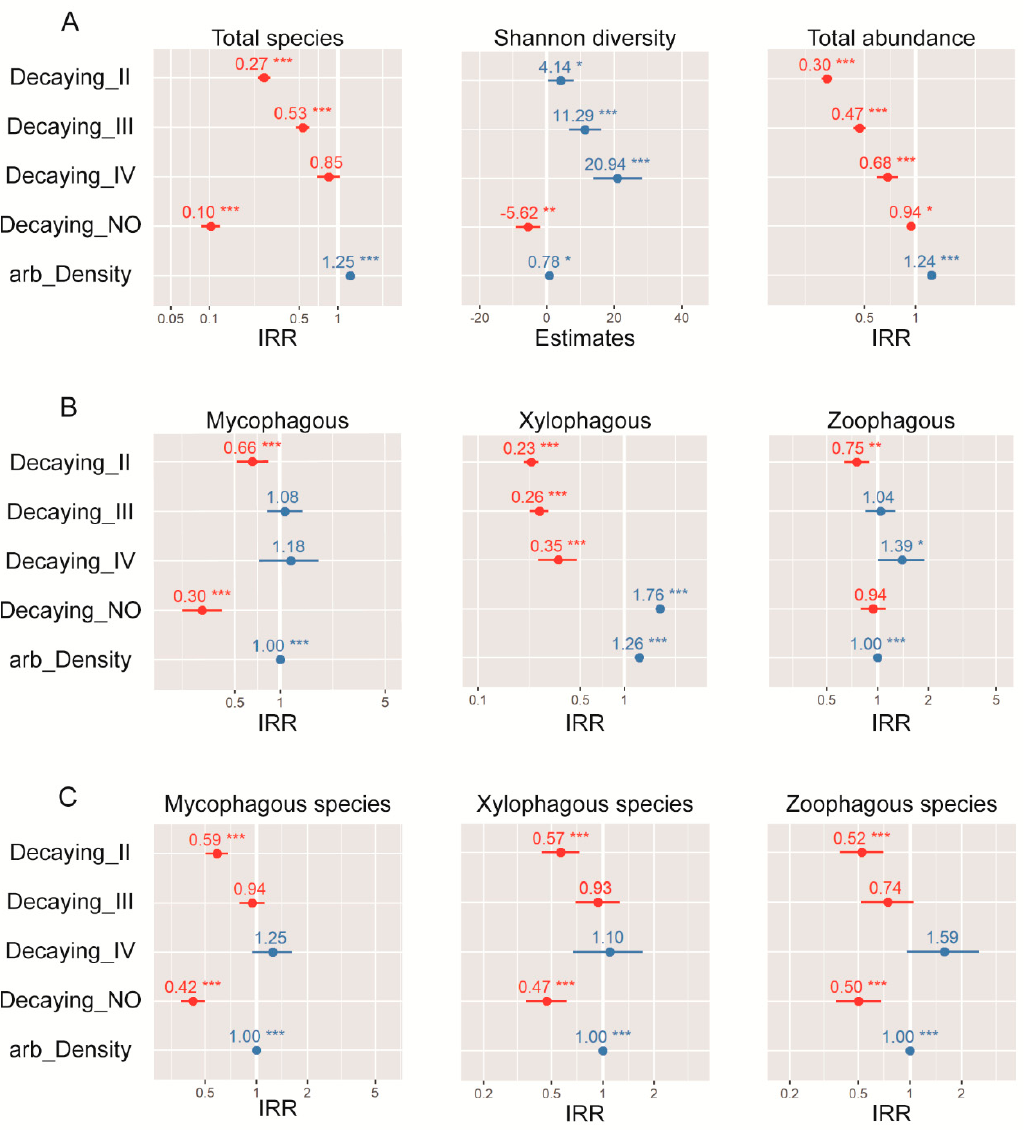
Figure 6. GLM results for ( A ) total community, trophic guilds ( B ) abundances, and ( C ) diversity of saproxylic beetles in unburned and burned conditions. For significance of incidence rate ratios (IRR) and estimate, the SE bar must not cross the 0.0 line. The further away from 0, the larger the effect; red and blue colors represent positive and negative effects, respectably. Asterisks (*) refer to significant estimate (* <0.05, ** <0.01, *** <0.001). Fits of the models are represented in Table 3.